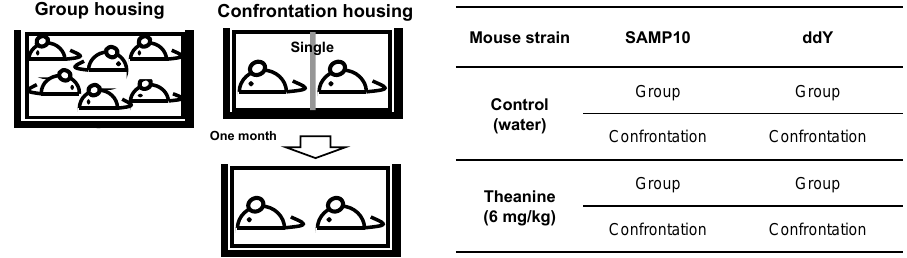
Figure 1. Experimental protocol.